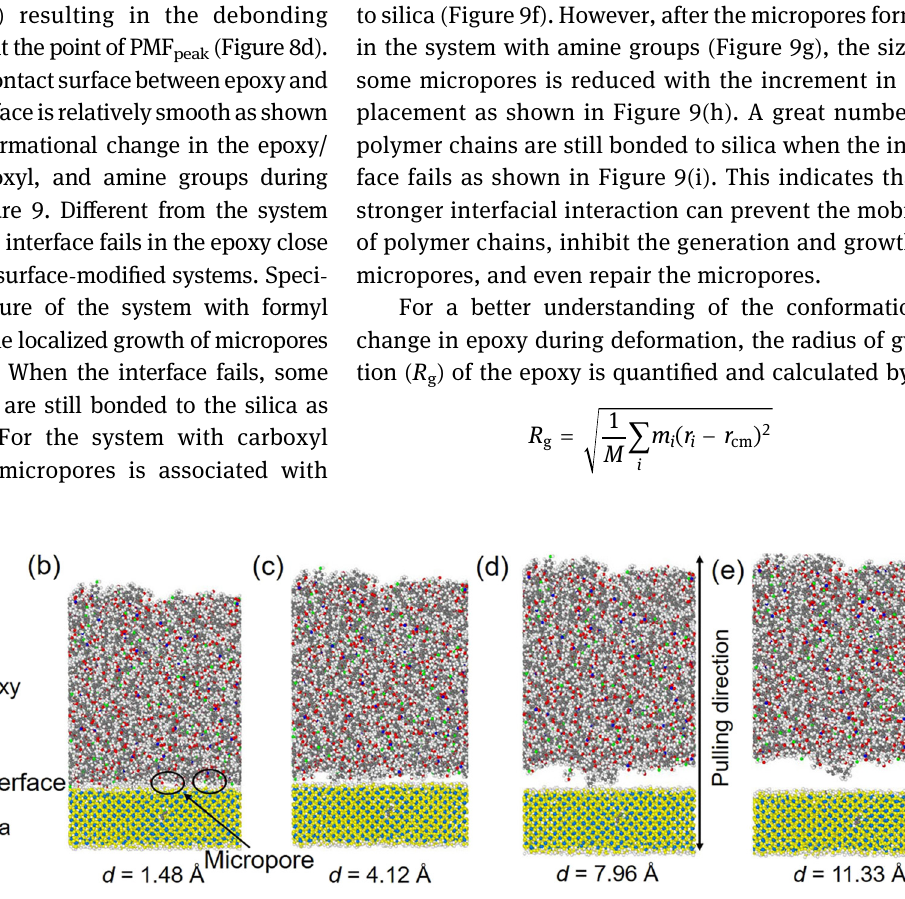
Table 1: The interfacial properties of di ff erent epoxy/silica systems, including the functional groups density, interfacial bonding energy ( E ) , the maximum pulling force ( F bonding Model